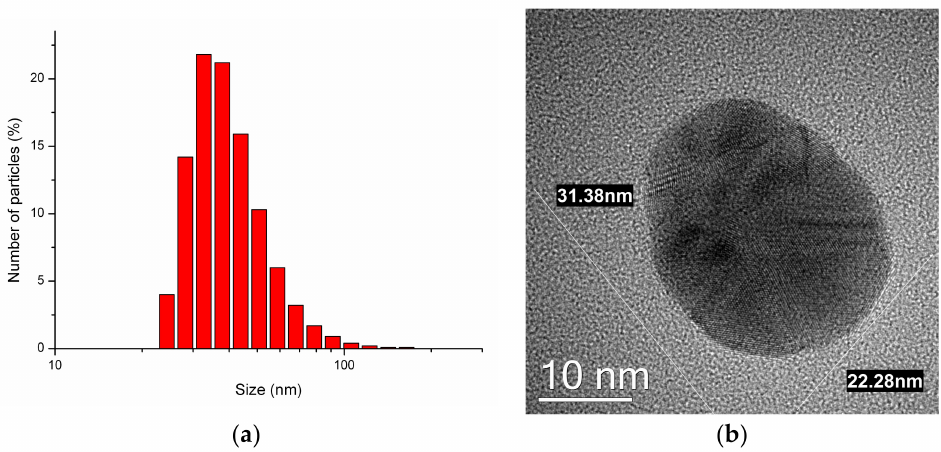
Figure 1. ( a ) Distribution of a number of particles by size for the initial measurements with Argovit C delivered with Dynamical Light Scattering (DLS); ( b ) Microphotograph of Argovit C silver nanoparticle Ag-NP visualized by Transmission Electron Microscopy (TEM).